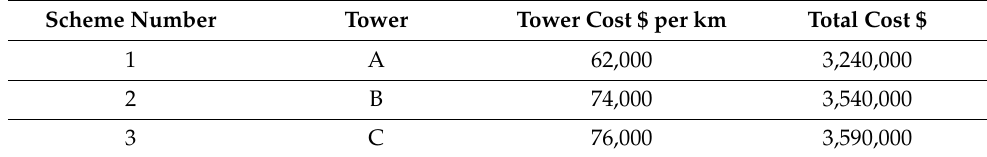
Table 9. Cost comparison of different